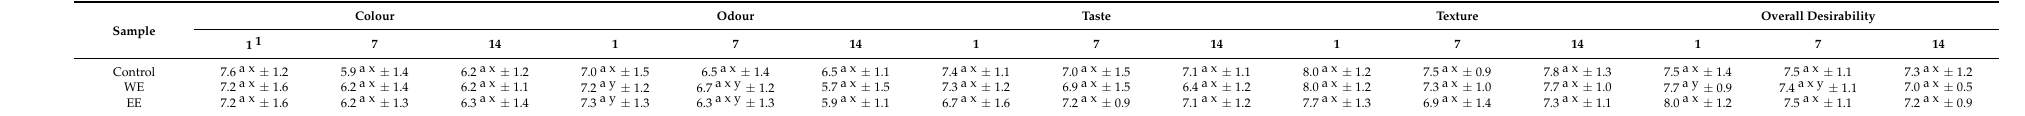
Table 4. Evolution of sensory attributes of chicken meatballs during refrigerated